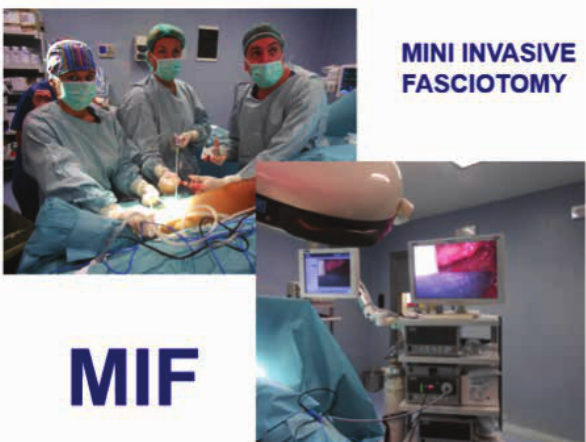
Figure 1: Mini invasive fasciotomy is performed by endoscopic tech- nique, the skin incision of about 1 cm is performed at the middle third of the lateral and medial surface of the leg, the assistant holds camera and the first operator performs fasciotomy by mini laparo- scopic scissors under vision.